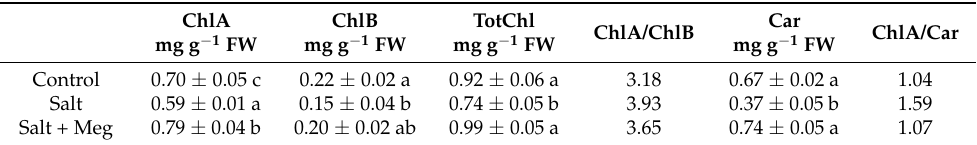
Table 2. Chlorophyll a (ChlA), chlorophyll b (ChlB), total chlorophyll (TotChl), ChlA/ChlB ratio, carotenoids (Car) and ChlA/Car ratio recorded in maize seedling controls, and grown with NaCl alone, and NaCl with the biostimulant (i.e., Control, Salt, Salt + Meg, respectively). ChlA mg g − 1 FW